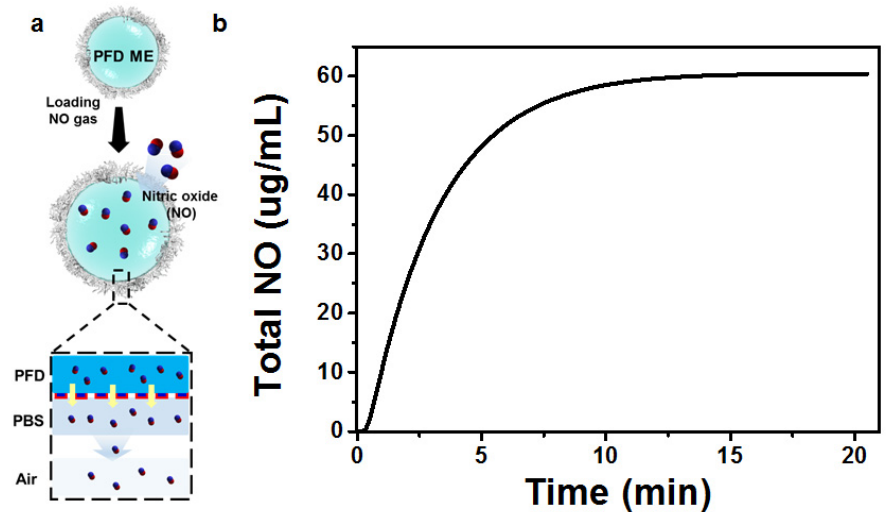
Figure 4. Schematic illustration of encapsulation of NO in PFC liquid cores of PFD nanodroplets stabilized with ssABP and its release ( a ) and accumulated amount of NO released from PFD-nanodroplets over time ( b ).